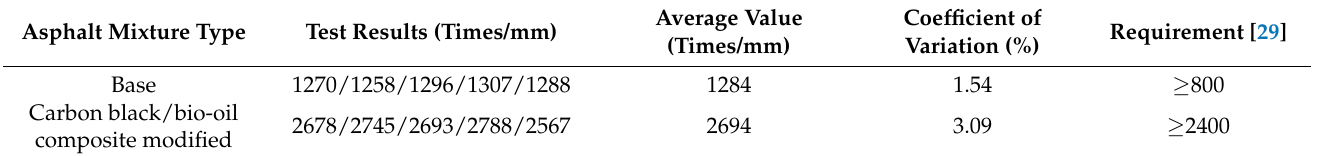
Table 9. DS results of different asphalt mixtures.